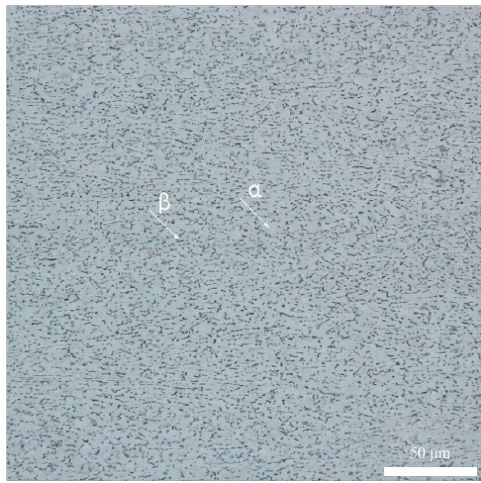
Figure 3. The microstructure of the base metal.